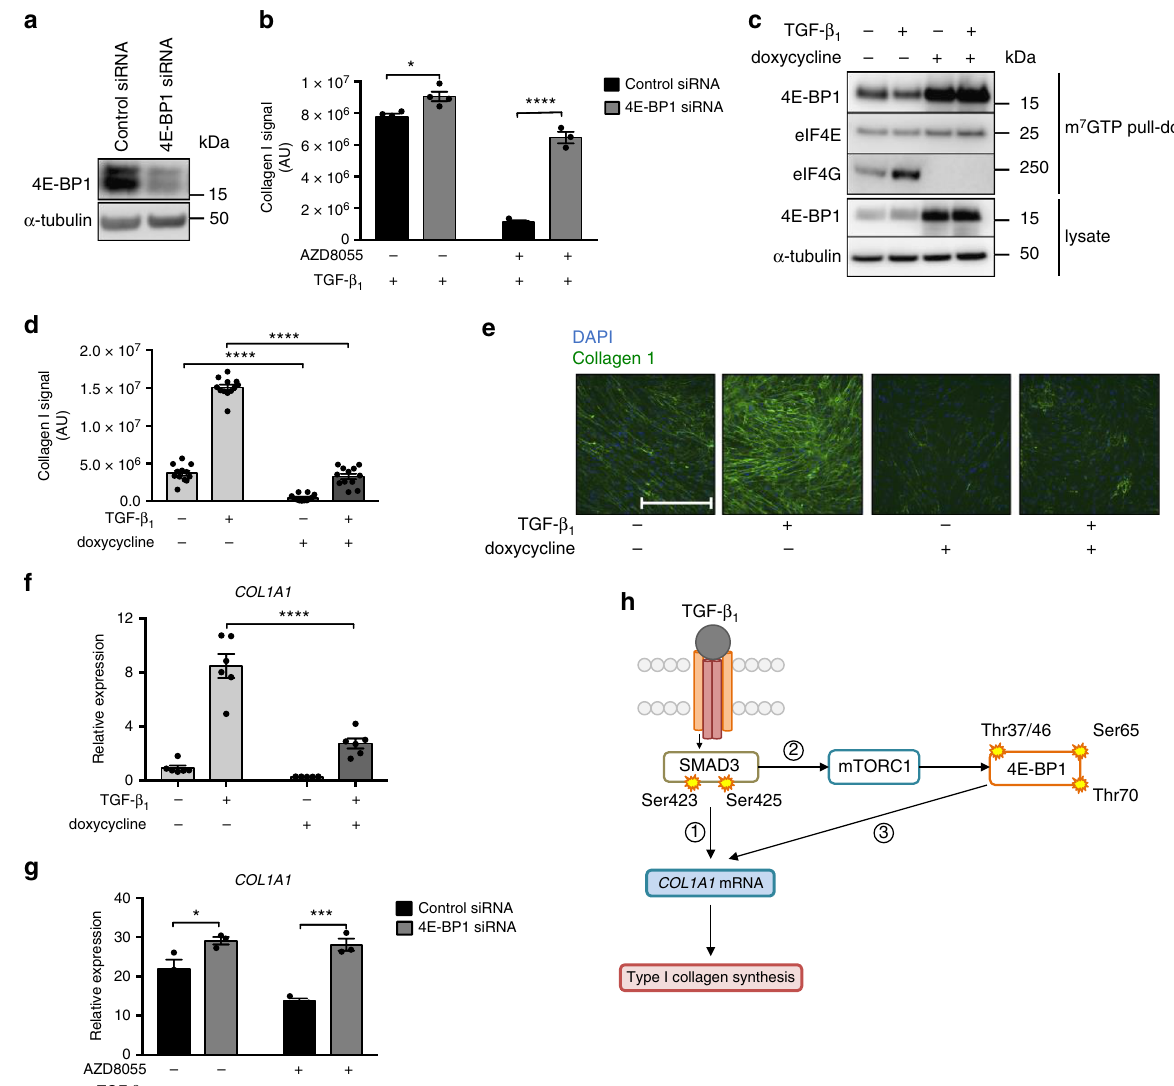
Fig. 6 mTORC1/4E-BP1 axis mediates the TGF- β 1 collagen I response in pHLFs. pHLFs were transfected with control siRNA or siRNA targeting 4E-BP1. 4E- BP1 protein expression was measured by Western blot ( a ). Following transfection, pHLFs were preincubated with 1 μ M AZD8055 or vehicle (0.1% DMSO) prior to stimulation with TGF- β 1 (1 ng/ml) for 72 h. Collagen I deposition was assessed by macromolecular crowding assay ( n = 4) ( b ). COL1A1 mRNA levels at 24 h were assessed by real-time RT qPCR ( n = 3) ( g ). pHLFs expressing a 4E-BP1-4A dominant-negative phosphomutant were treated with doxycycline (1 μ g/ml) or media control for 24 h prior to TGF- β 1 stimulation. Immunoprecipitation of the m 7 GTP cap was performed and protein levels assessed by Western blot ( c ). Collagen deposition was measured at 72 h by macromolecular crowding assay ( n = 12) ( d ). Representative images are shown in e . Scale bars = 360 µ m. COL1A1 mRNA levels were measured at 24 h (n = 6) ( f ). Data are presented as means ± SEM. For real-time RT-PCR, relative expression was calculated using 2 − Δ Ct . Δ Ct was calculated from the geometric mean of two reference genes. For collagen deposition assays all data are expressed as collagen I signal ( n = 4 fi elds of view imaged per well) normalized to cell count. All data are representative of at least 3 independent experiments. Differences between groups were evaluated with two-way ANOVA with Tukey multiple comparison testing, * p < 0.05, *** p < 0.001, **** p